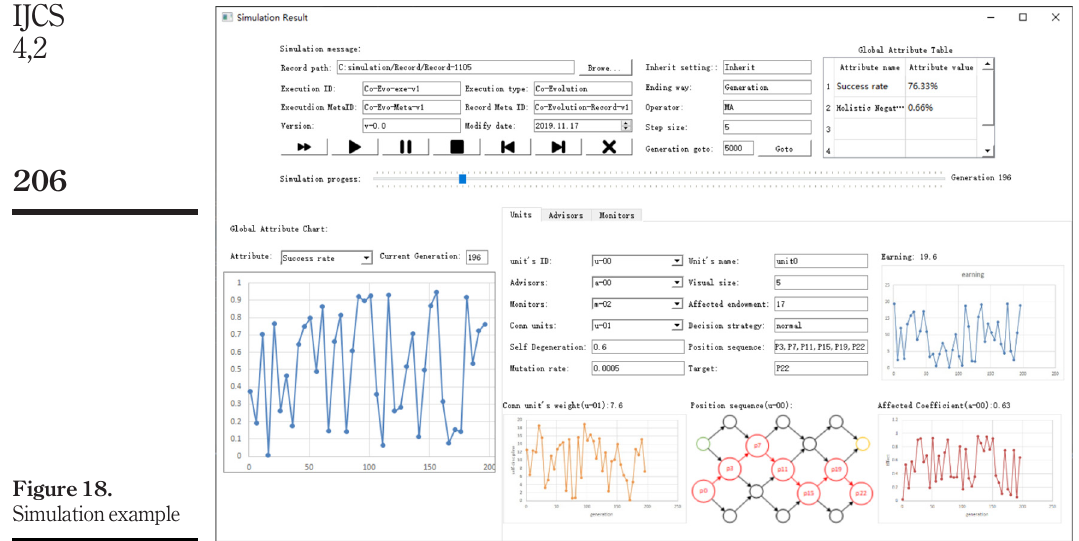
Figure 18. Simulation